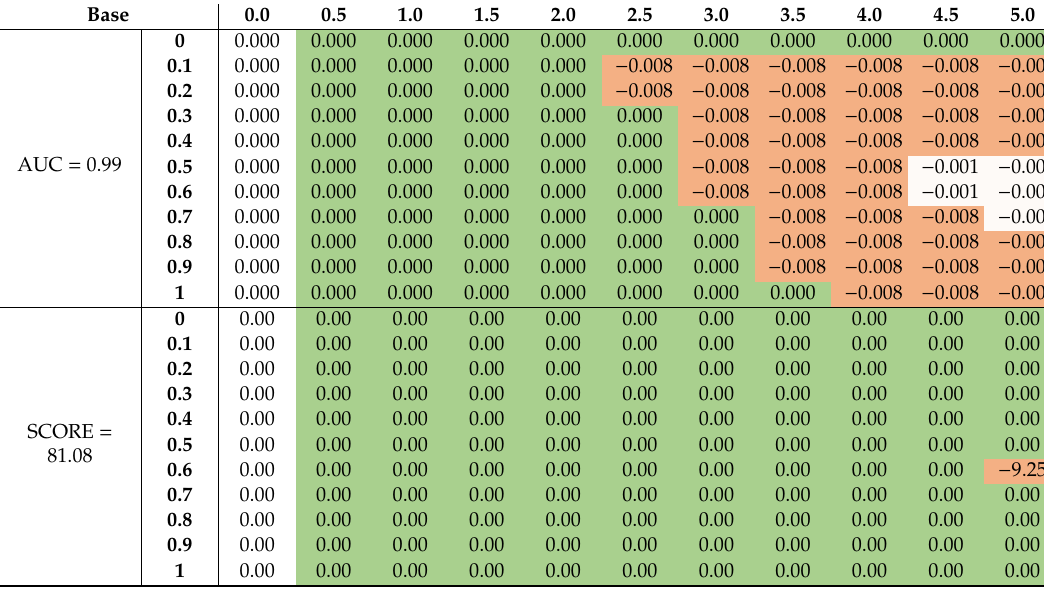
Table 6. Improvement of AUC and Score for Tachycardia on validation sample in terms of the α -parameter and p -parameter.